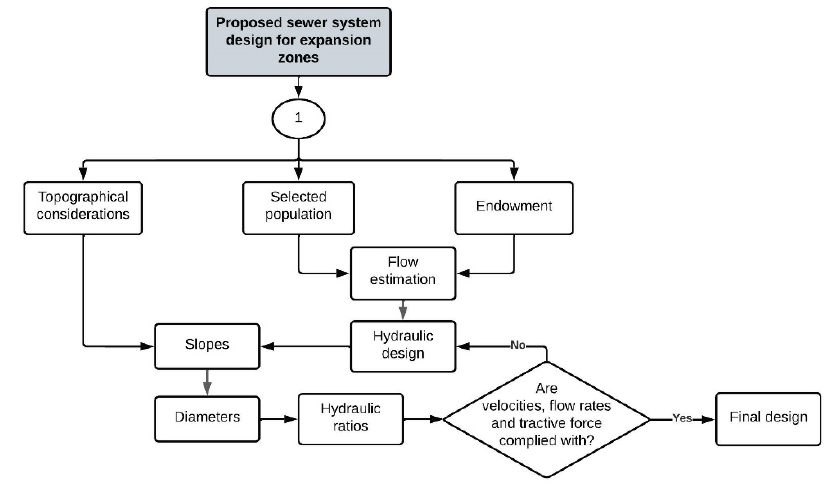
Figure 3. Methodological scheme for the design of sewerage in the expansion zones.